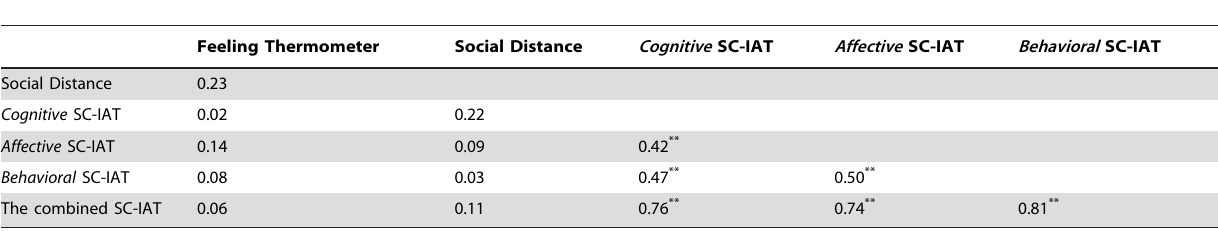
Table 3. Correlations between implicit and explicit measures among 56 members of the general